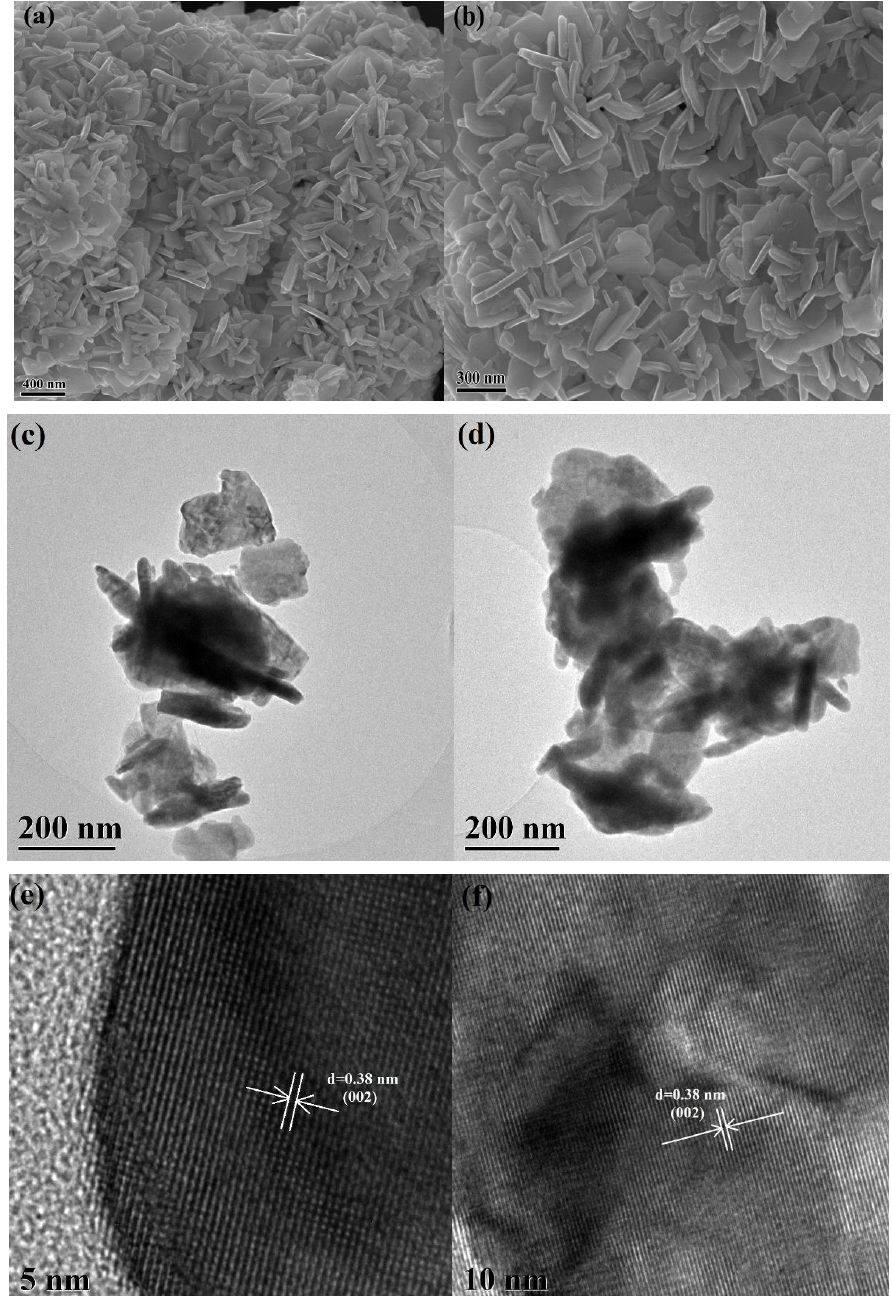
Figure 2. Field emission scanning electron microscopy (FE-SEM) images of the WO 3 ( a ) and WO 3 − x ( b electron microscopy (HR-TEM) images of the WO 3 ( e ) and WO 3 − x ( f ) nanosheets.